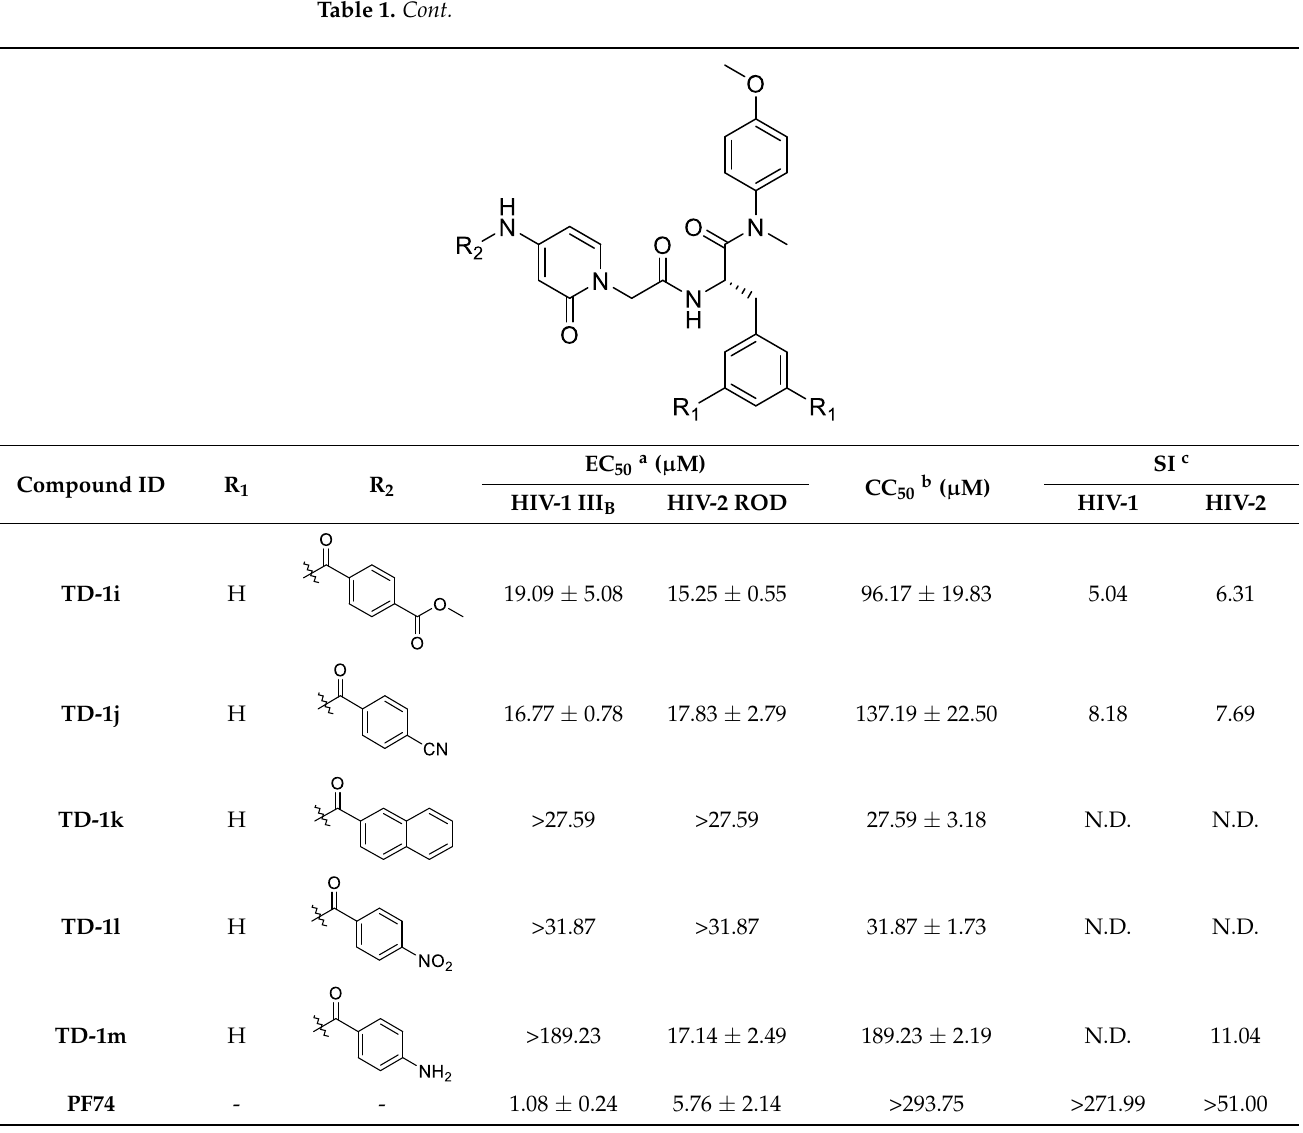
Table 2. Solubility of Representative Compounds.